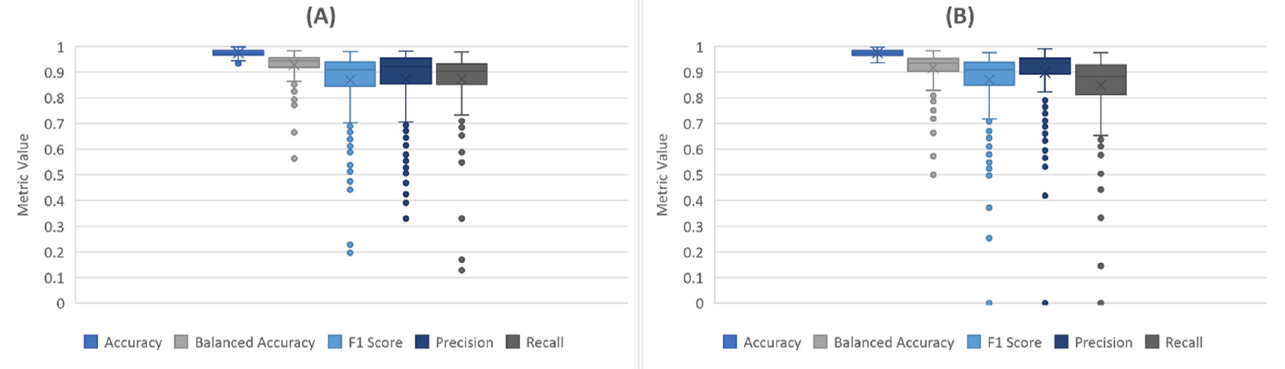
Figure 4. ( A ) Metrics for binary entropy unsupervised technique; ( B ) metrics for binary variance unsupervised technique.